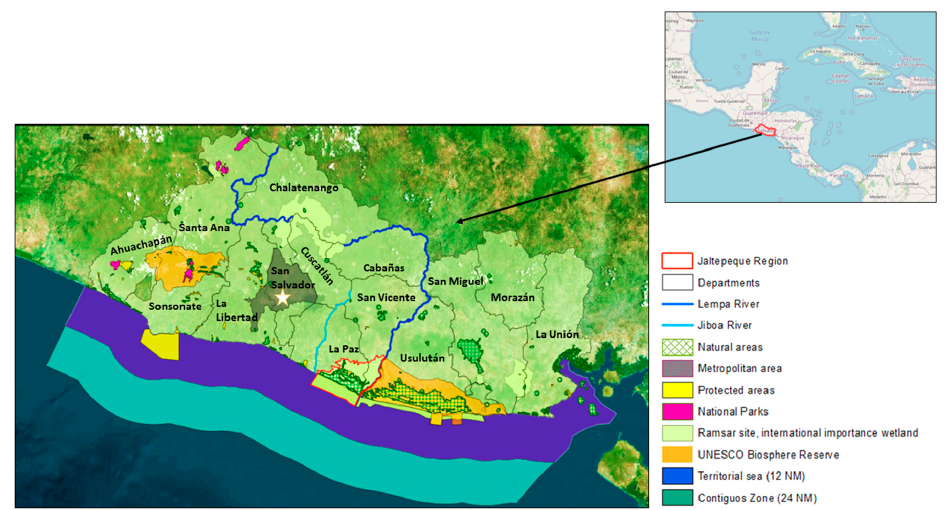
Figure 1. Location of the Jaltepeque region (bordered in red) in El Salvador (Central America). The figure shows the different types of conservation categories established in the area. The map has been elaborated and edited by Urbigis, a freely accessible tool. Through this link https://urbigis.com/0617ccee-8e40-4f66-8769-112f08fe809b.sel (accessed on 10 February 2021) it is possible to access and edit this map. You can find more information on handling the tool at https://help.urbithings.com/help/ (accessed on 10 February 2021).